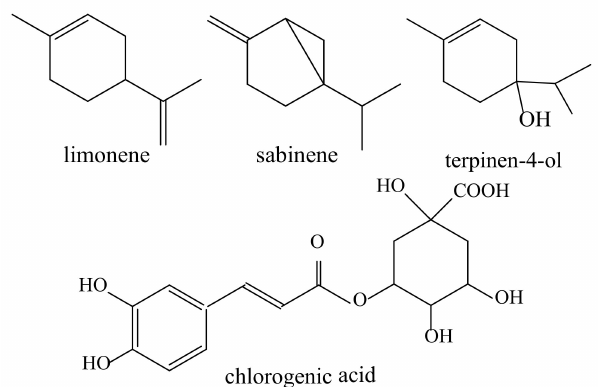
Figure 4. Major components detected in sea fennel essential oils, hydrolates and residual